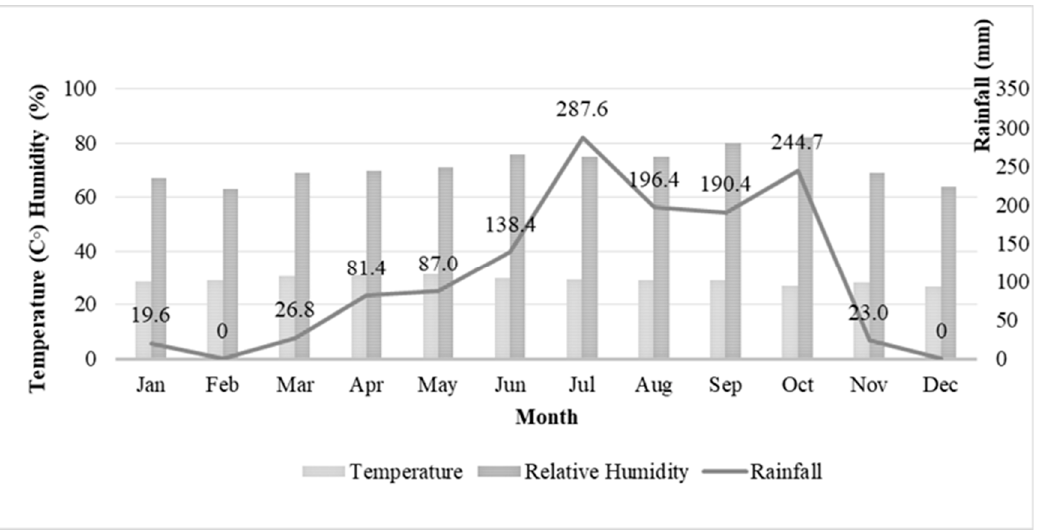
Figure 3. Monthly environmental parameters (mean temperature, relative humidity, and total rainfall) for study area.